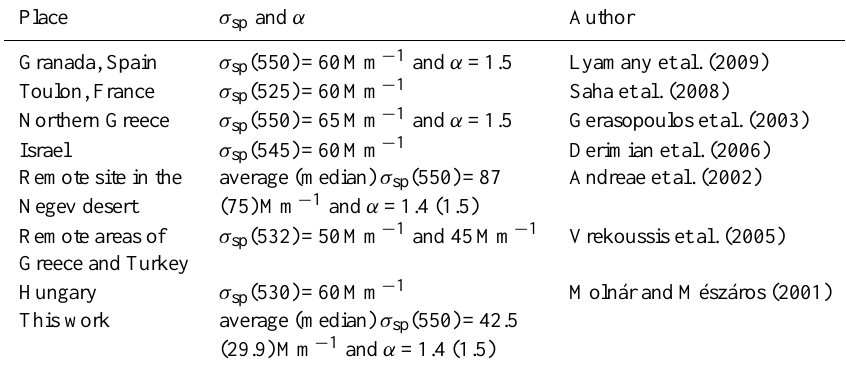
Table 4. Values of scattering coefficient and ˚Angstr¨om exponent obtained for long-term measurements performed at different sites. Place σ sp and α